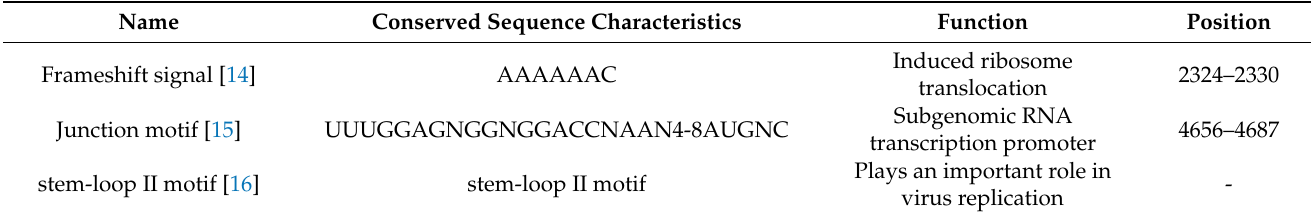
Table 2. Conserved sequence characteristics of the isolated